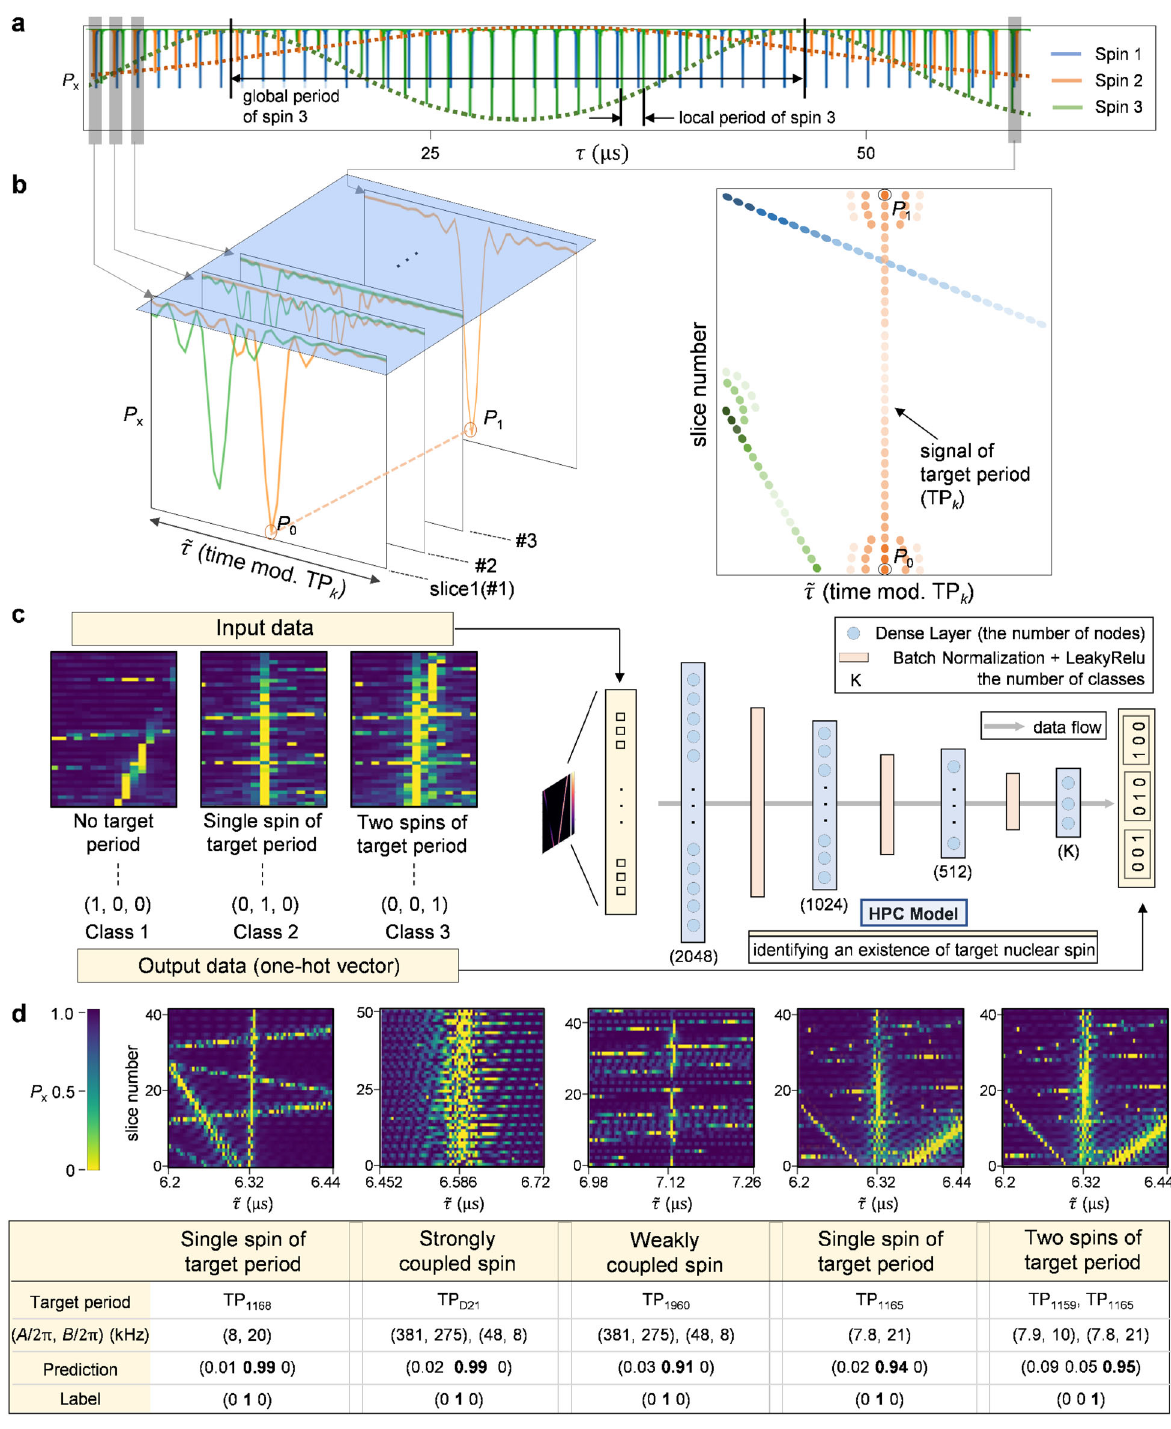
Fig. 2 Individual spin signature identi fi cation by hyper fi ne parameter classi fi er (HPC) deep learning model. a Simulated CPMG signal with three spins of different ( A , B ) values showing general features of nuclear spectra including local and global periods (see text for de fi nitions). b Concept of the data conversion into 2D images by slicing and stacking the data fragments with speci fi ed target period TP k . In this 2D image, the x-axis label ~ τ represents evolution time modulo TP k . The 2D image reveals the signature of a target signal as a vertical line with vanishing slope, which is generally superposed with other interfering nuclear spin signals. c Training datasets and architecture of the HPC model in a case of classifying three classes (K = 3), where K is the number of nodes of the last layer. The input data consists of three different classes, where each class corresponds to the number of existing nuclear spins with the target period, and the output data is one-hot vector form assigned to each class. For example, Class 1 (Class 2) means that no (one) spin with the target period exists. d Example predictions of the HPC model depending on hyper fi ne coupling strength ( fi rst to third panels) and proximity to similar period (fourth and fi fth panels). For all cases, the HPC model predicts correct spin signatures corresponding to input signals showing good consistency between the predicted vectors and the output vectors. (for example, in the fi rst panel, the predicted vector is (0.01 0.99 0) and the output vector is (0 1 0)). The color scale bar in all 2D images ranges from 0 to